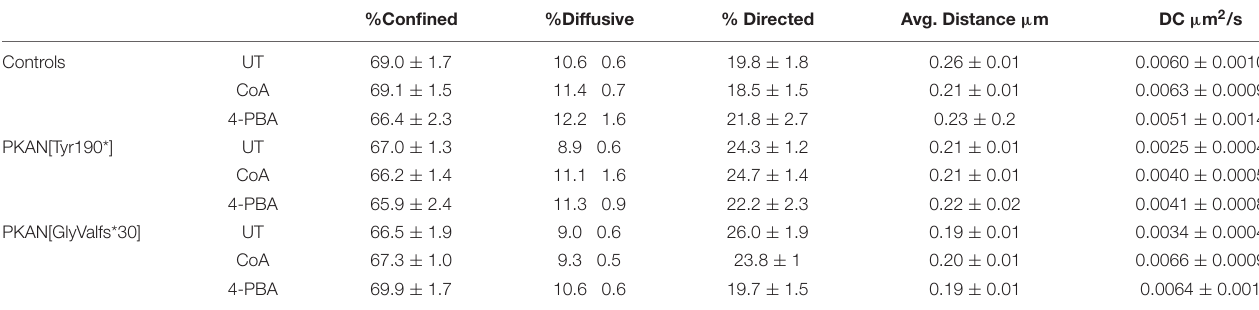
TABLE 3 | Diffusional features of motile